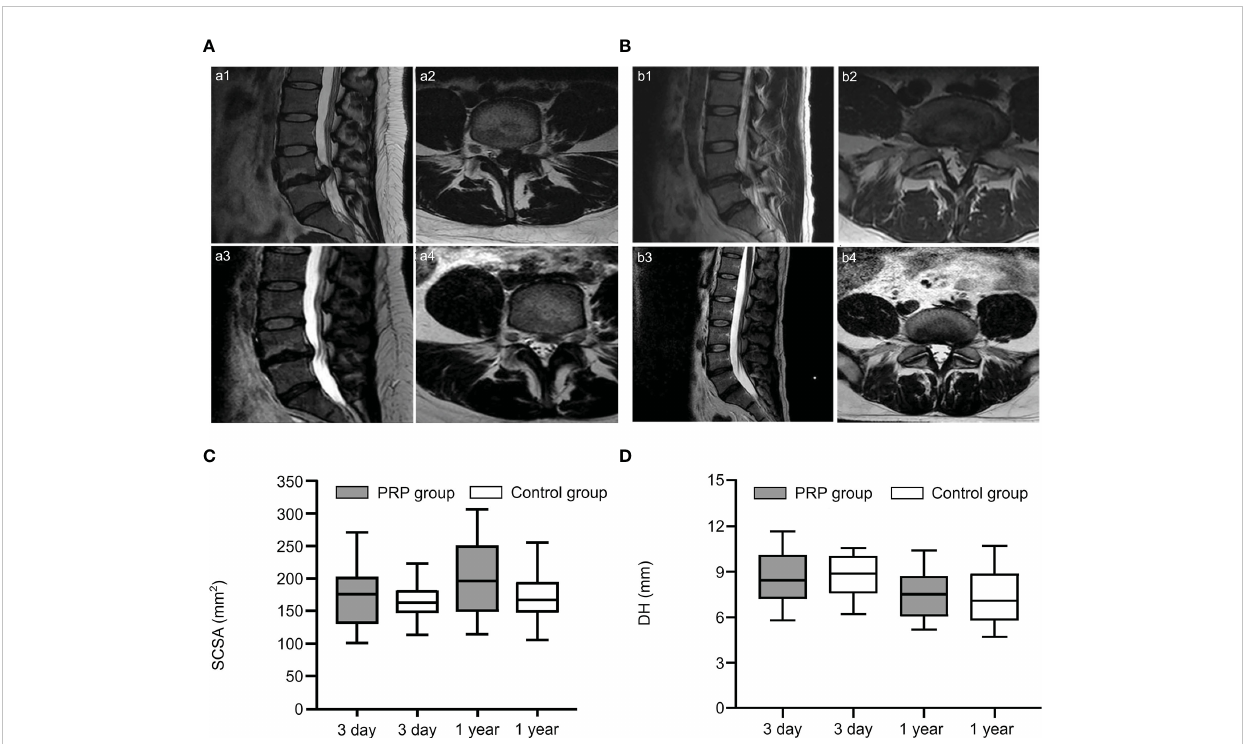
FIGURE 2 PRP treatment of lumbar disc herniation. (A, B) Sagittal and axial slices showed signi fi cant disc resorption before and after epidural injection of PRP in two patients. Sagittal (a1, b1) and axial (a2, b2) MRI images showed lumbar disc herniation in two patients before treatment; Sagittal (a3, b3) and axial (a4, b4) images showed signi fi cant disc resorption after treatment. (C, D) Comparison of spinal cord cross-sectional area (SCSA) and disc height (DH) on MRI at 3 and 1 years after treatment. Reproduced with permission from (60,